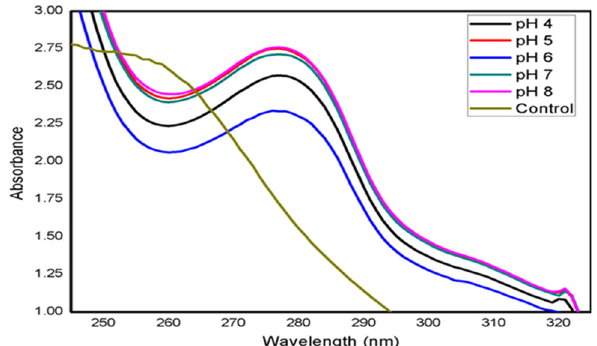
Figure 2: The optical spectra presents the e ff ect of pH on the green synthesis of Pt NPs ( reprinted from ref. [ 124 ] , copyright 2020, with permission from Elsevier )